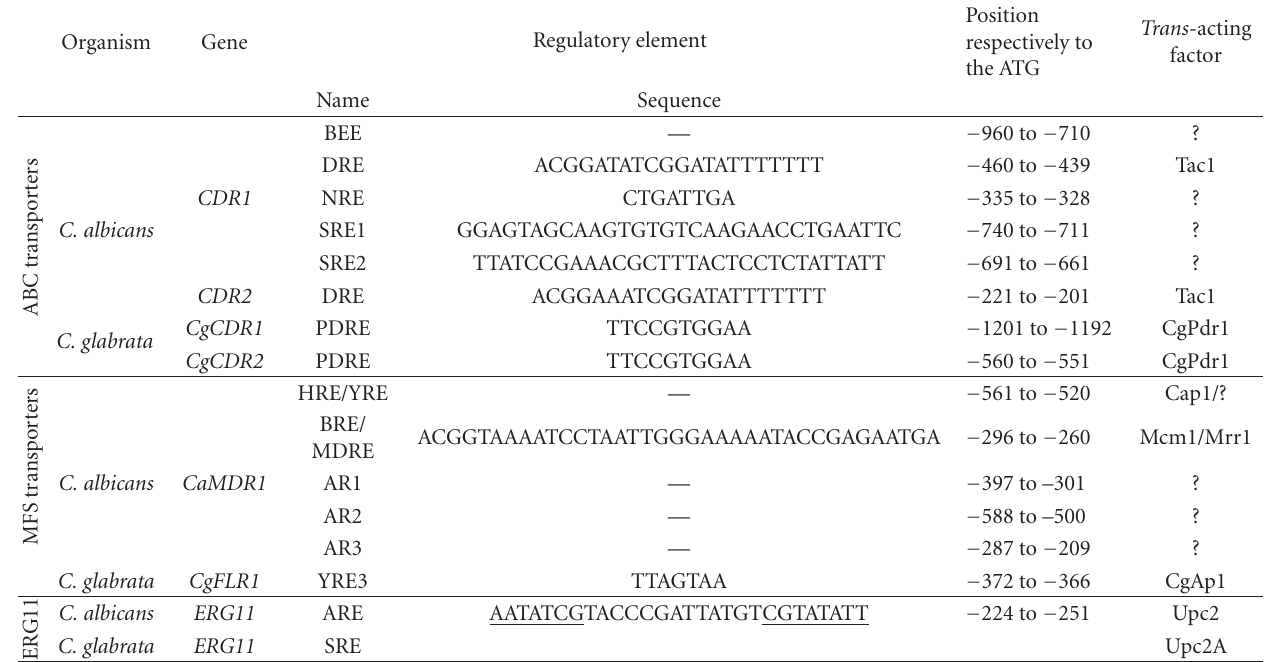
Table 3: Cis -acting elements involved in drug